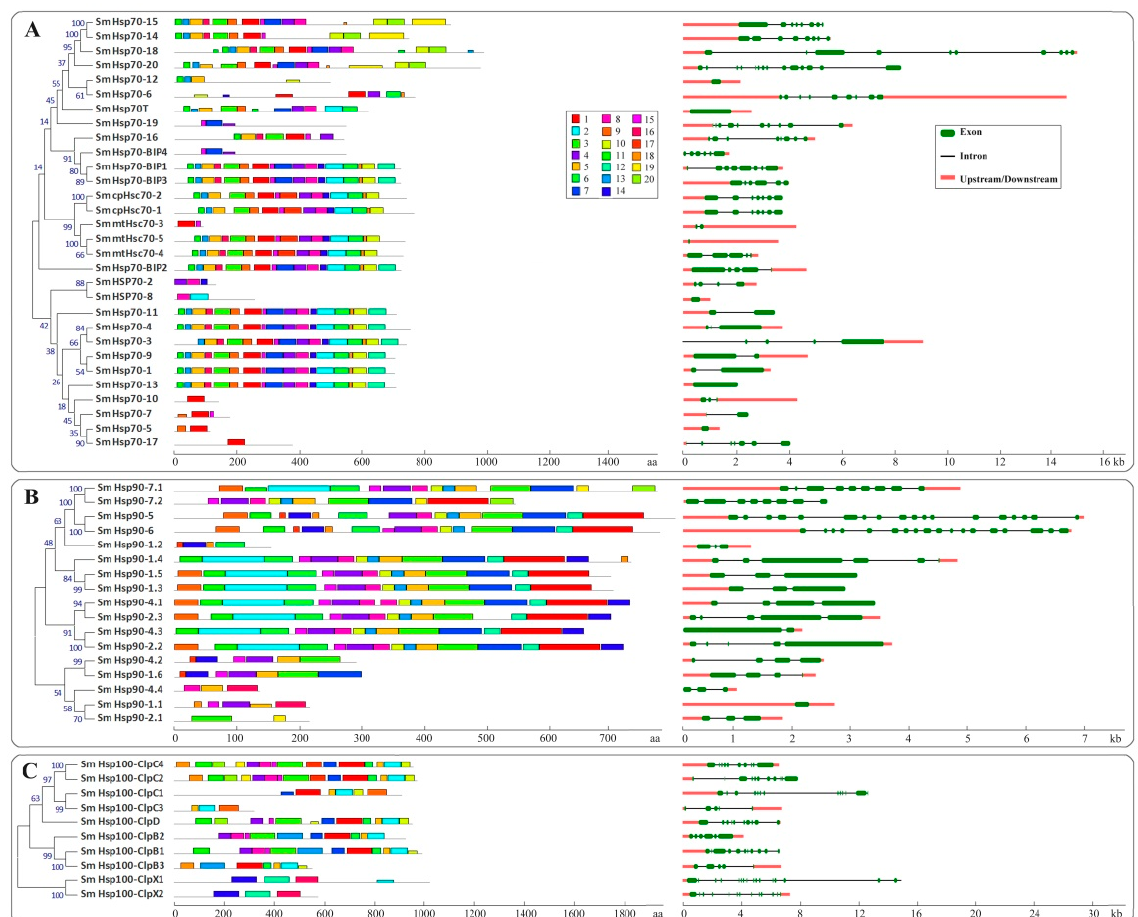
Figure 2. Phylogenetic relationships, gene structures and motif compositions of the Hsp70, Hsp90 and Hsp100 family members in S. melongena (Sm). Multiple alignment of the Hsp70 ( A ), Hsp90 ( B ) and Hsp100 ( C ) proteins from S. melongena (Sm) was performed with MEGA 5.0 using the neighbor-joining (NJ) method with 1000 bootstrap replicates (left panel). A schematic representation of conserved motifs (obtained using MEME) in the Hsp70 ( A ), Hsp90 ( B ) and Hsp100 ( C ) proteins is displayed in the right panel. Different motifs are represented by differently colored boxes. Details of the individual motifs are in Tables S11–S13. The exon/intron structures of the Hsp70 ( A ), Hsp90 ( B ) and Hsp100 ( C ) genes are shown in the middle panel. Green boxes represent exons and black lines represent introns.